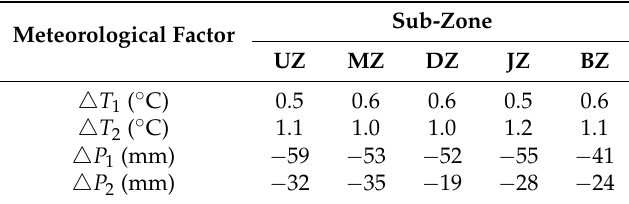
Table 11. Annual average change in temperature and precipitation during the 1990s and 2000s compared with the baseline